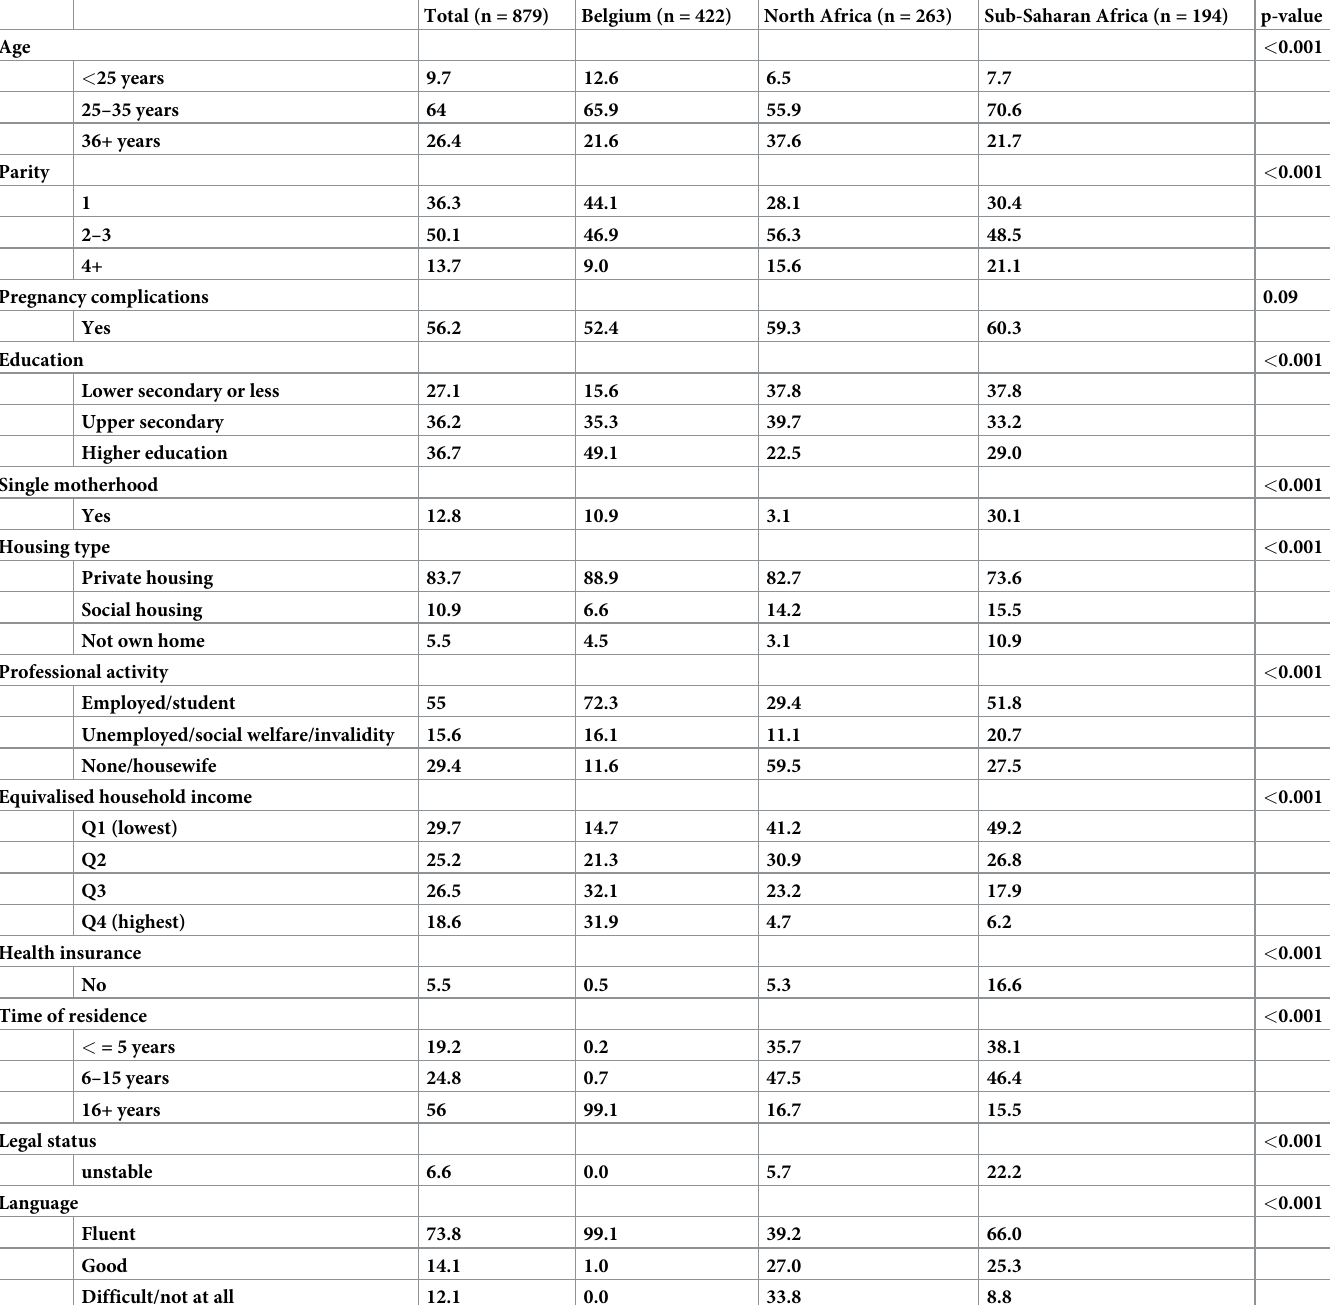
Table 1. Demographic, clinical, and socioeconomic characteristics of women (in %), overall and by region of birth, with X 2 p-values. Total (n = 879) Belgium (n =